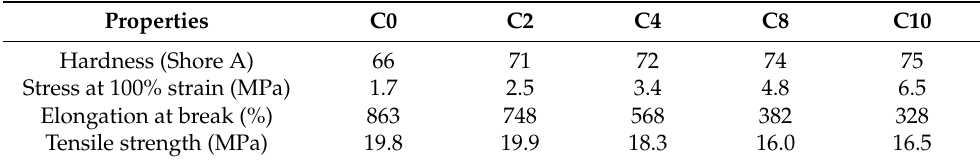
Table 2. Mechanical properties of EPDM/silica/CNTs composites.